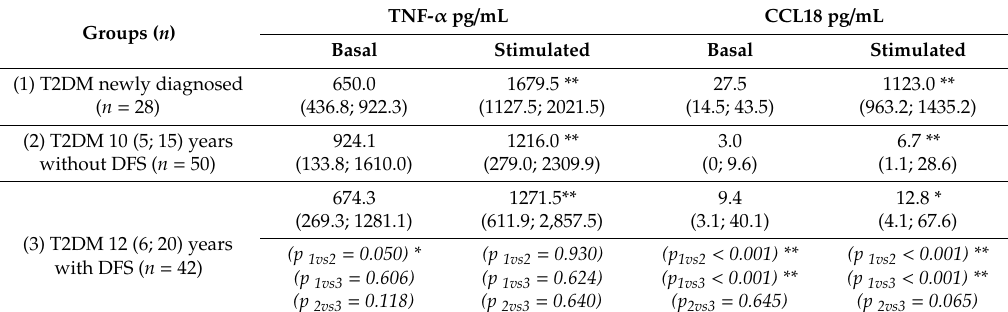
Table 2. Basal and stimulated TNF- α and CCL18 secretion by blood-derived monocytes from patients with